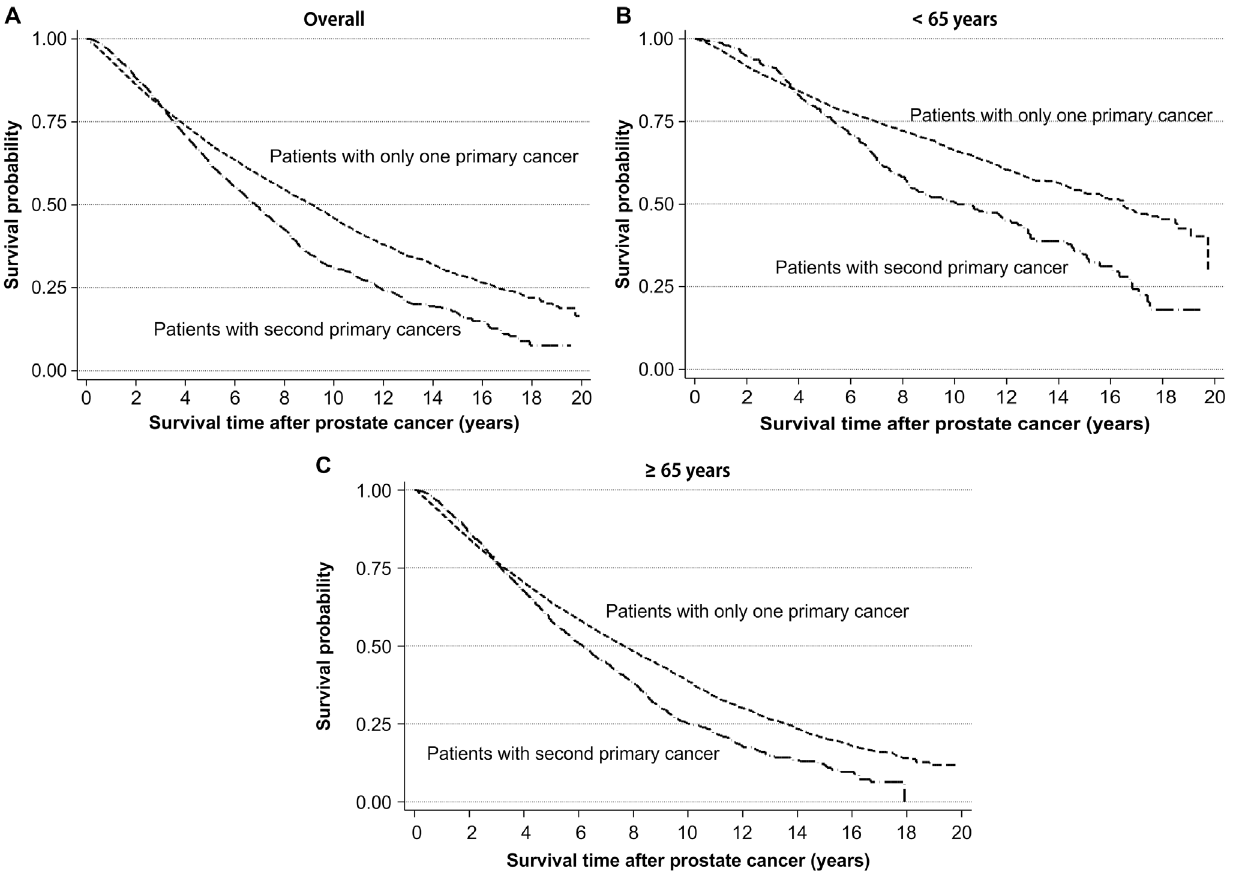
Fig 1. Kaplan-Meier curves showing survival after diagnosis of prostate cancer according to the presence of a second primary cancer. (A) All patients, (B) patients aged < 65 years, (C) patients aged (cid:1) 65 years.